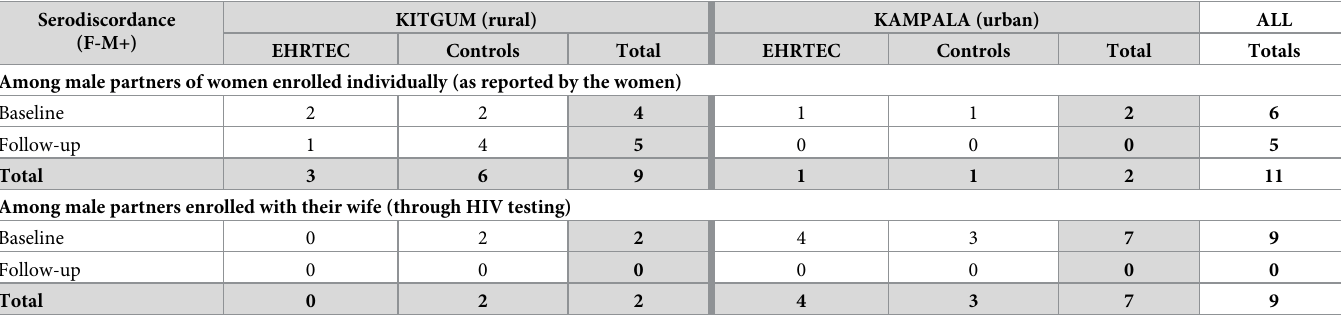
Table 1. Serodiscordant couples (F-M+) at baseline and during follow-up. Serodiscordance KITGUM (rural) KAMPALA (urban) ALL (F-M+) EHRTEC Controls Total EHRTEC Controls Total Totals Among male partners of women enrolled individually (as reported by the women)